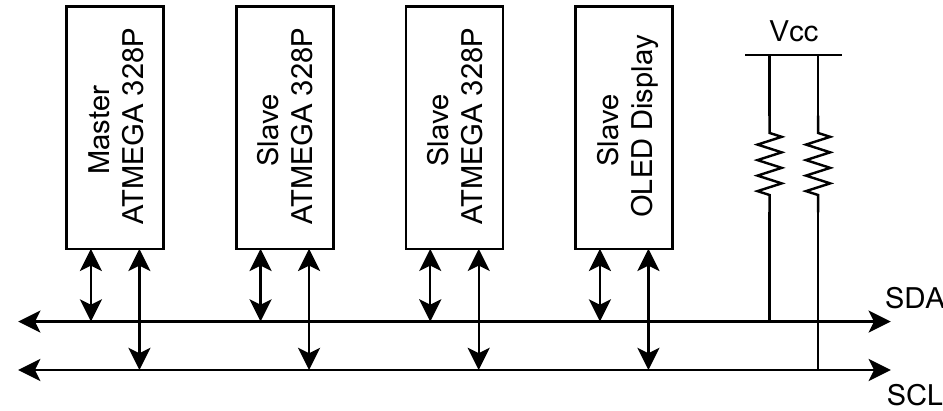
Figure 5. I2C bus connection